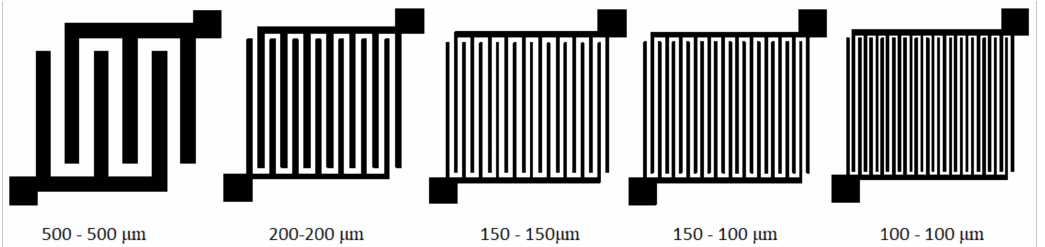
Figure 3. Design of sensor interdigital electrodes for polymeric substrate (gap width-electrode